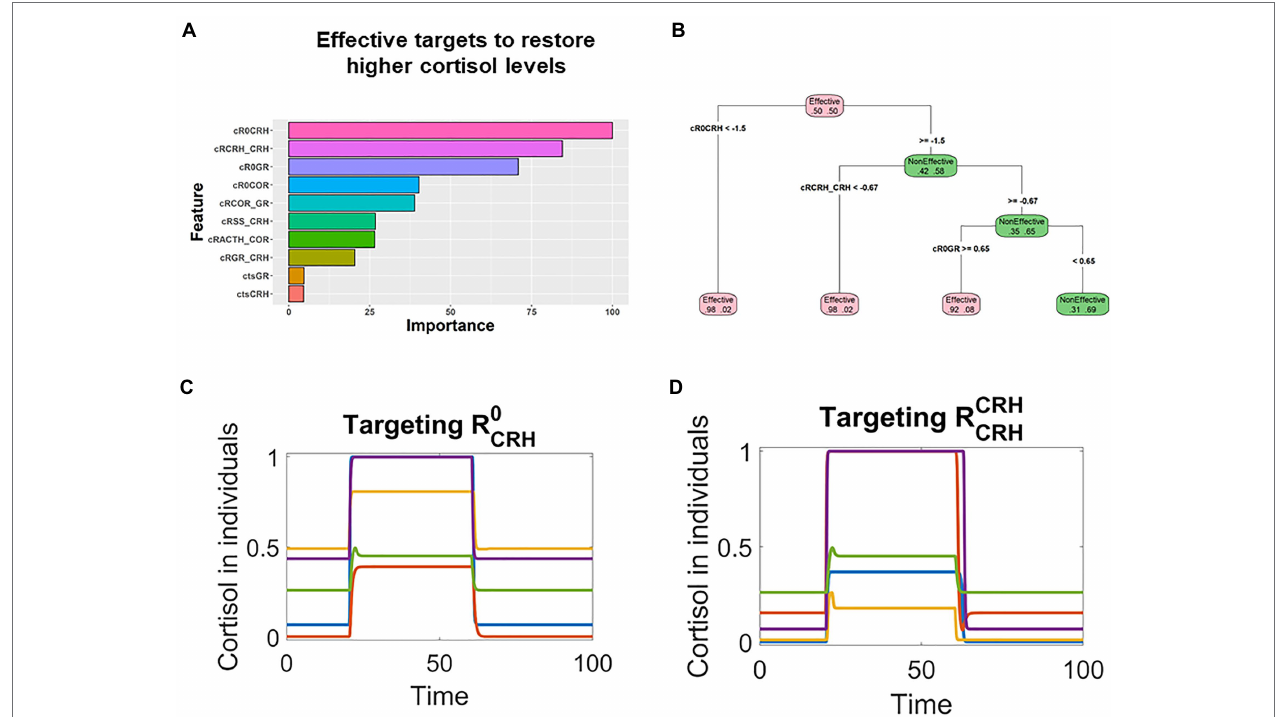
FIGURE 5 | Machine learning analysis revealed that parameters controlling the CRH positive feedback were associated with effective treatments for patients with higher cortisol levels. (A) Random forest analysis ranked the targets based on their association with the effective treatments in patients whose pathological cortisol levels were higher. (B) Decision tree analysis indicated that these key parameters should be decreased for the treatments to be effective. (C,D) Time series 0 R CRH simulations illustrated how the decrease of CRH or R CRH restored the cortisol levels in patients who had higher levels of cortisol after stress stimulation.